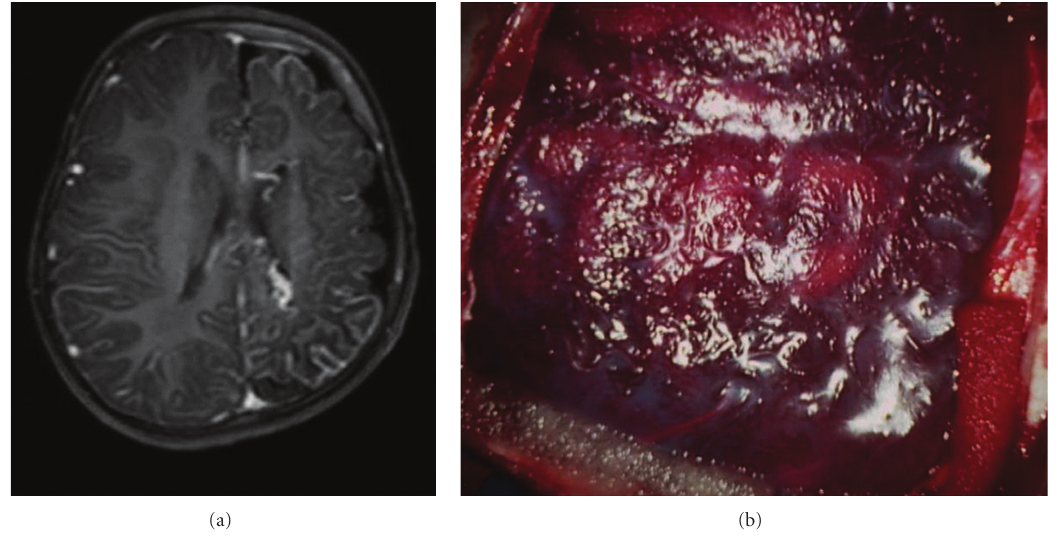
Figure 6: (a) T1W Axial gadolinium MRI image of a patient with Sturge Weber disease showing left hemispheric leptomeningeal angiomatosis, (b) intraoperative